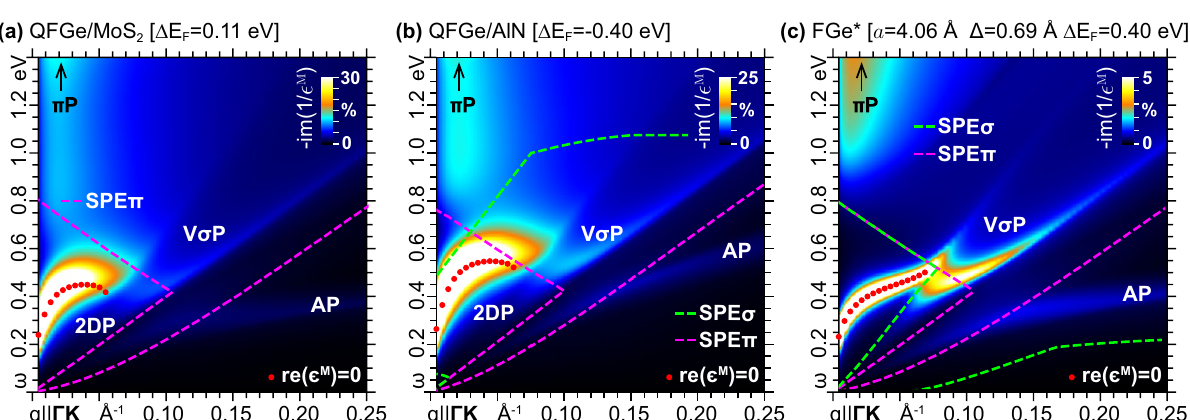
Figure 6. Loss functions (in arb. units) of QFGe on MoS 2 , displayed as density maps vs ω< 1.4 eV and Ŵ K , for different doping or gating conditions, with the Fermi level driven from the intrinsic q < 0.08Å − 1 , with q (cid:31) state ( a ) to the Dirac cone vertex ( b ), passing from an intermediate position ( c ). The color scale is normalized to the maximum intensity of the ω< 0.4 eV mode, with the red dots labeling the undamped plasmon resonances, and the dominant plasmon modes marked as in Fig. 5. The dashed lines delimit the regions where one-electron excitations, involving the π and π ∗ bands, occur around the K point (SPE π ), and one-electron excitations, involving the σ and σ ∗ bands, occur around the Ŵ point (SPE σ ).